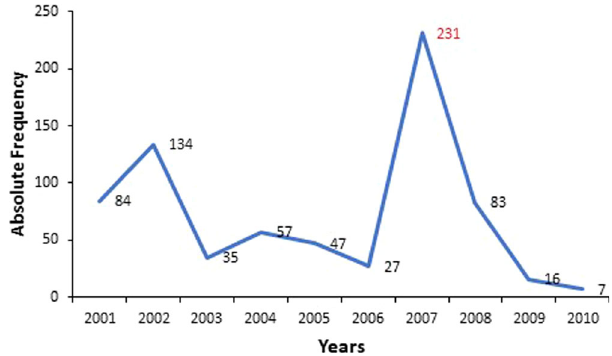
Fig. 1 Time pattern. Time-speci fi c pattern of Musharraf* .